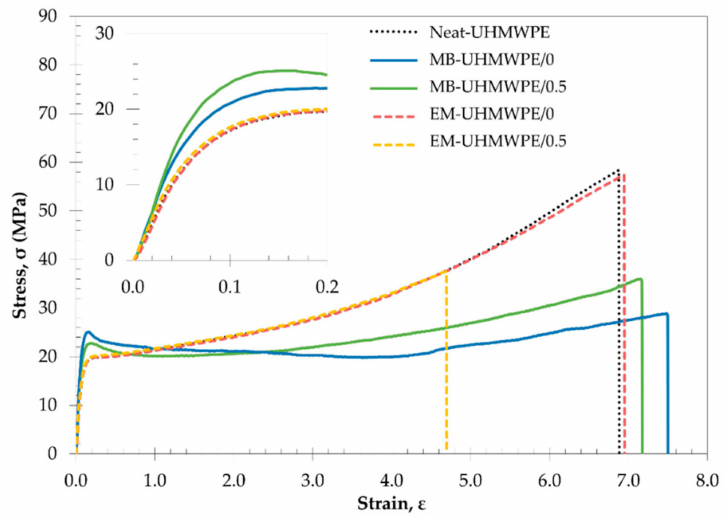
Figure 2. Representative engineering stress-strain curve of the neat UHMWPE and UHMWPE/CNF bionanocomposites showing differences in Young’s modulus (inlet with lower strain regime), yield strength and fracture